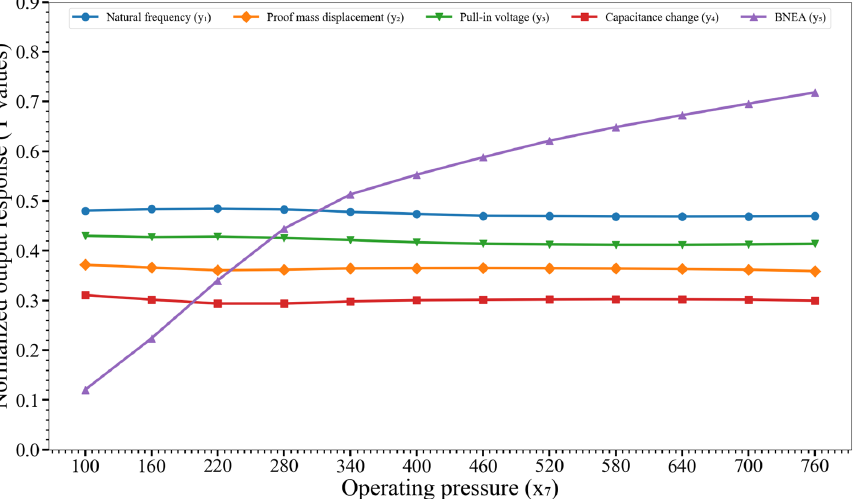
Figure 13. E ff ect of variation of the operating pressure (x 7 ) on the output responses y 1 , y 2 , …, y 5 .